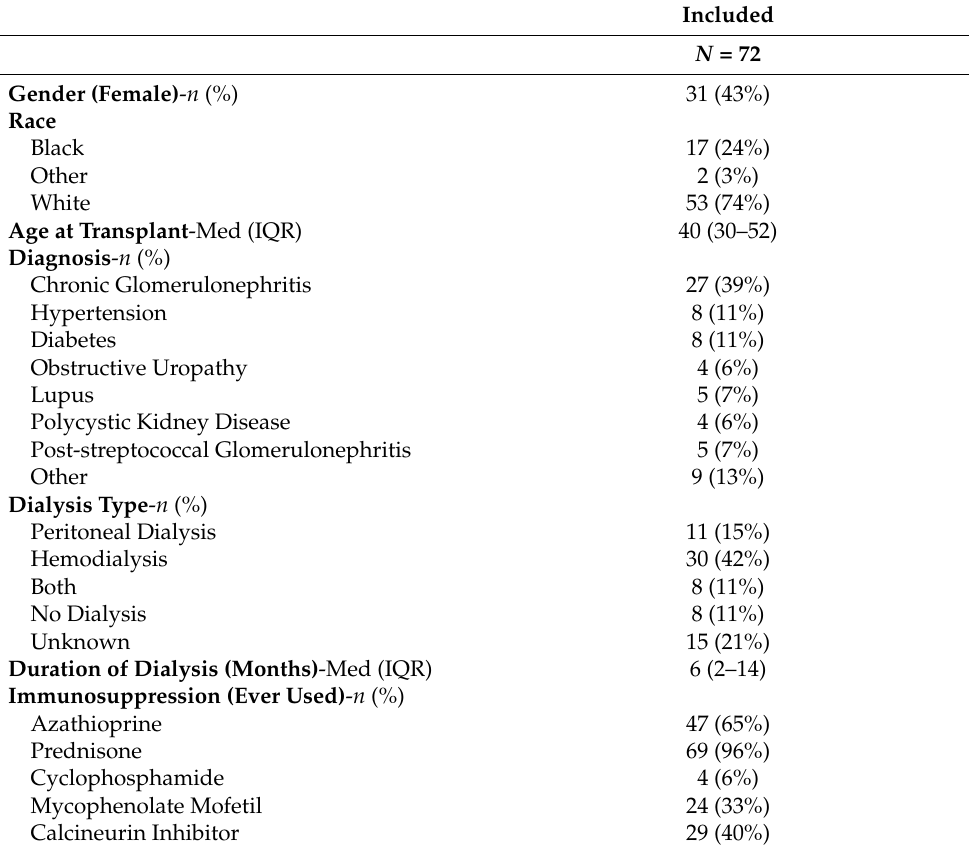
Table 1. Duke Cohort